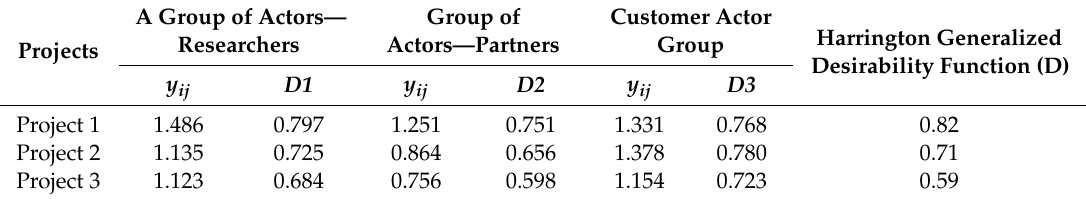
Table 6. Interpretation of standard marks on the Harrington scale for ecosystem